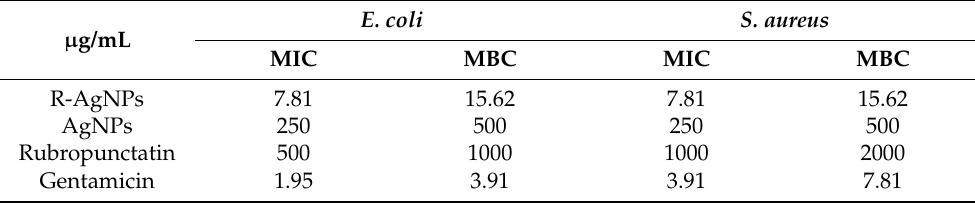
Table 2. The MIC and MBC (in µ g/mL) of the R-AgNPs, AgNPs, rubropunctatin and gentamicin against E. coli and S. aureus .